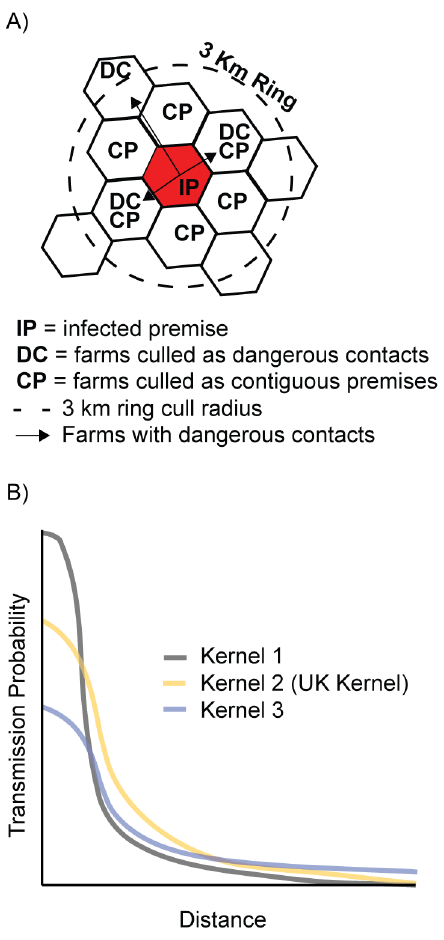
Figure 1. Candidate management actions and alternative dispersal models for the FMD case study. (A) Schematic representing the four possible nested management actions (IP only [IP], IP + DC [DC], IP + DC + CP [CP], IP + DC + 3 km ring culling [RC]) for FMD management (corresponding to Table 1, step B). (B) Three alternative dispersal kernel models for FMD in the UK, representing a continuum of possible dispersal kernels (corresponding to Table 1, step C).